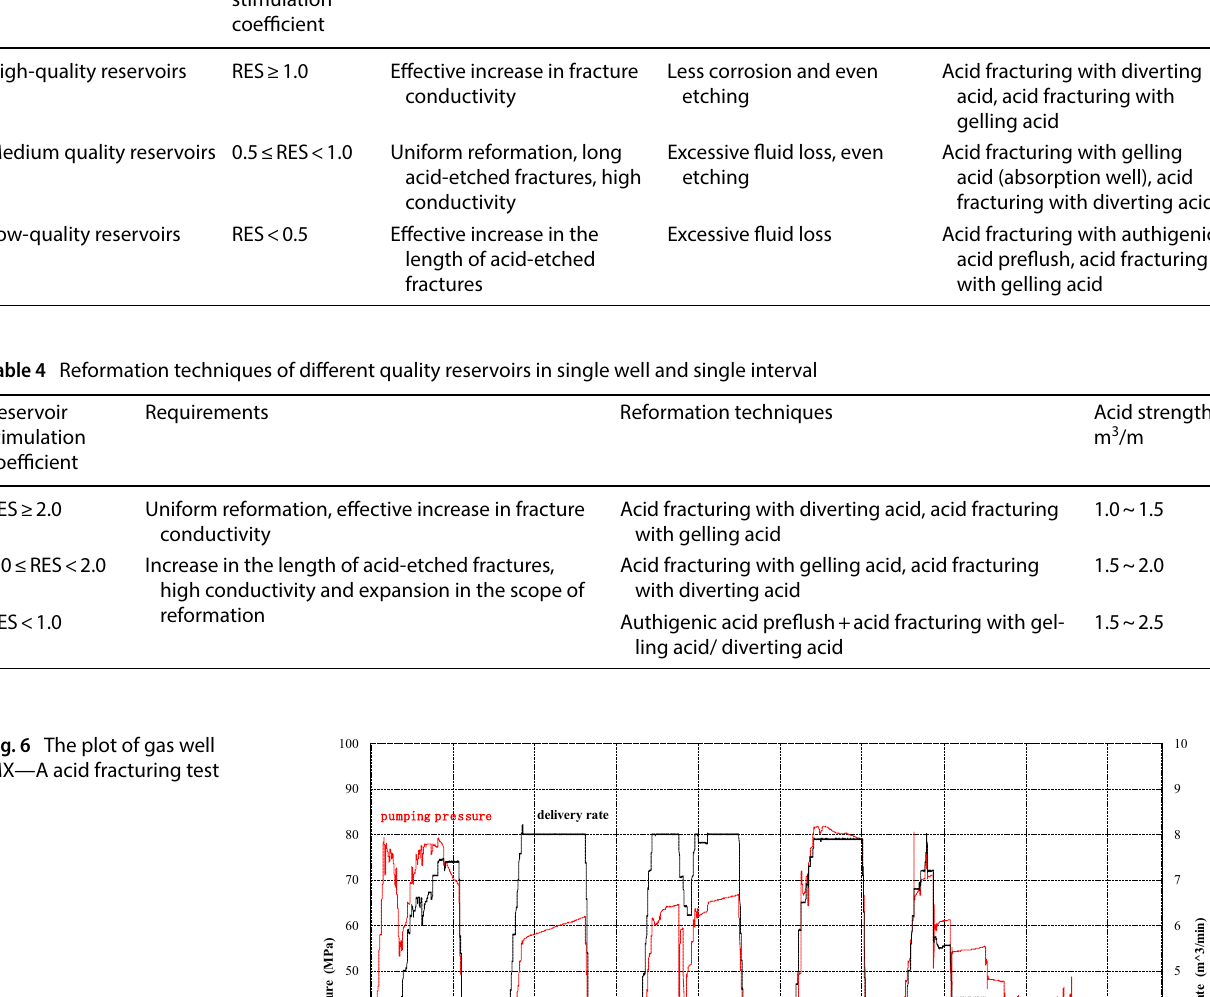
Table 3 Requirements for reservoir renovation of different grades and targeted reformation techniques Types of reservoir